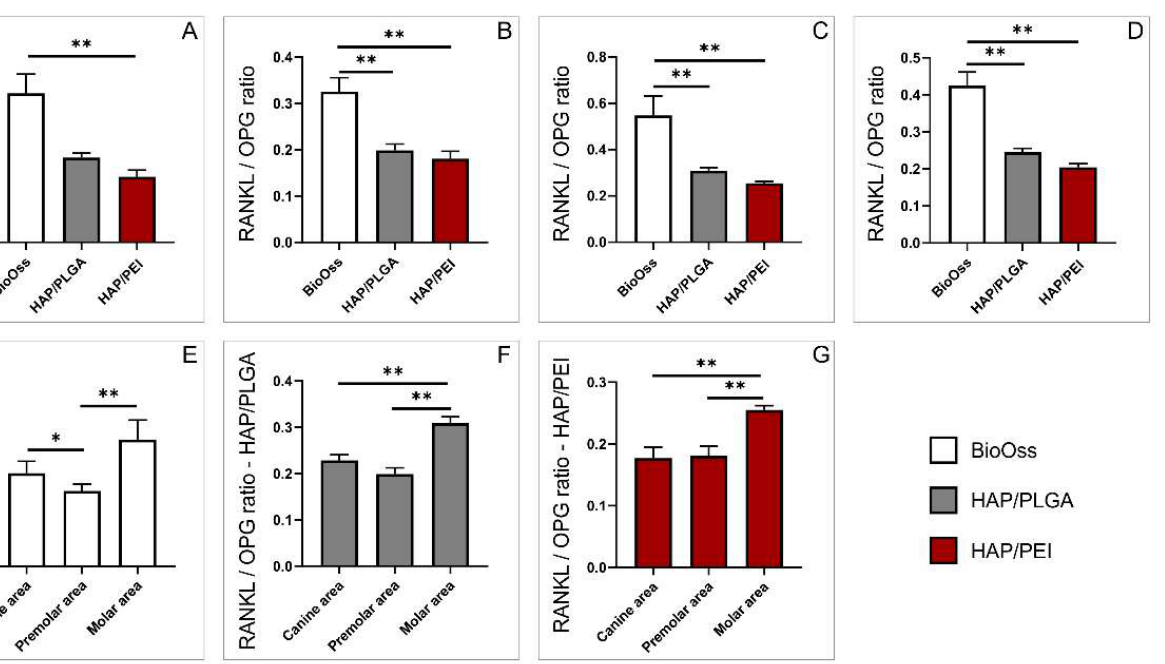
Figure 7. Relative expression of OPG gene: ( A ) canine area, ( B ) premolar area, ( C ) molar area, ( D ) whole mandibula, ( E ) BioOss graft, ( F ) HAP/PLGA graft, ( G ) HAP/PEI graft. The values are mean ± standard error of the mean (SEM), * denotes a significant difference p < 0.05, ** denotes a significant difference p < 0.01.